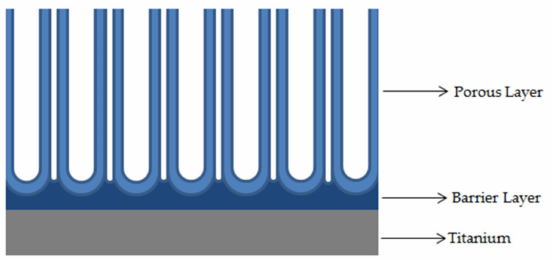
Figure 2. A sketch of the nanotubes layer formed on titanium sheet characterized by the presence of an outer ordinated porous layer and an inner compact layer, known as the barrier